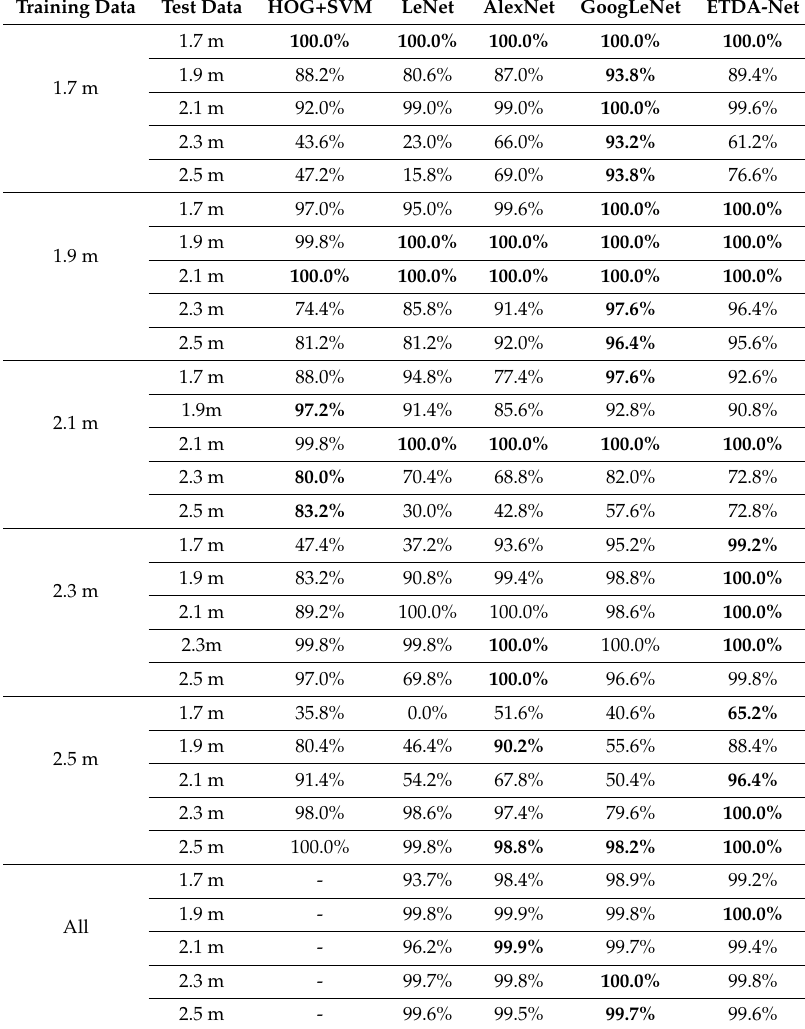
Table 4. Experimental results from sensitivity